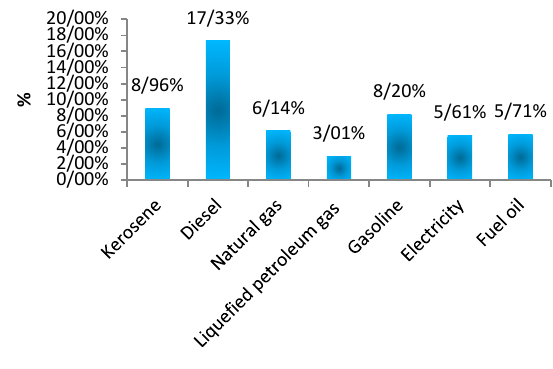
Figure 2. The consumption share of energy carriers in food and beverage industries of Iran.